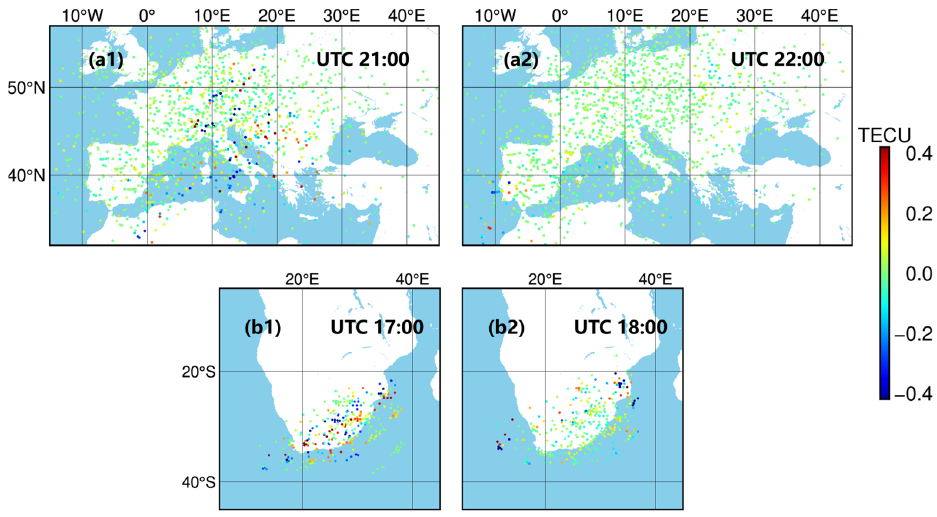
Figure 6. The propagation of TID in Europe ( a1–a2 ) and South Africa ( b1–b2 ).